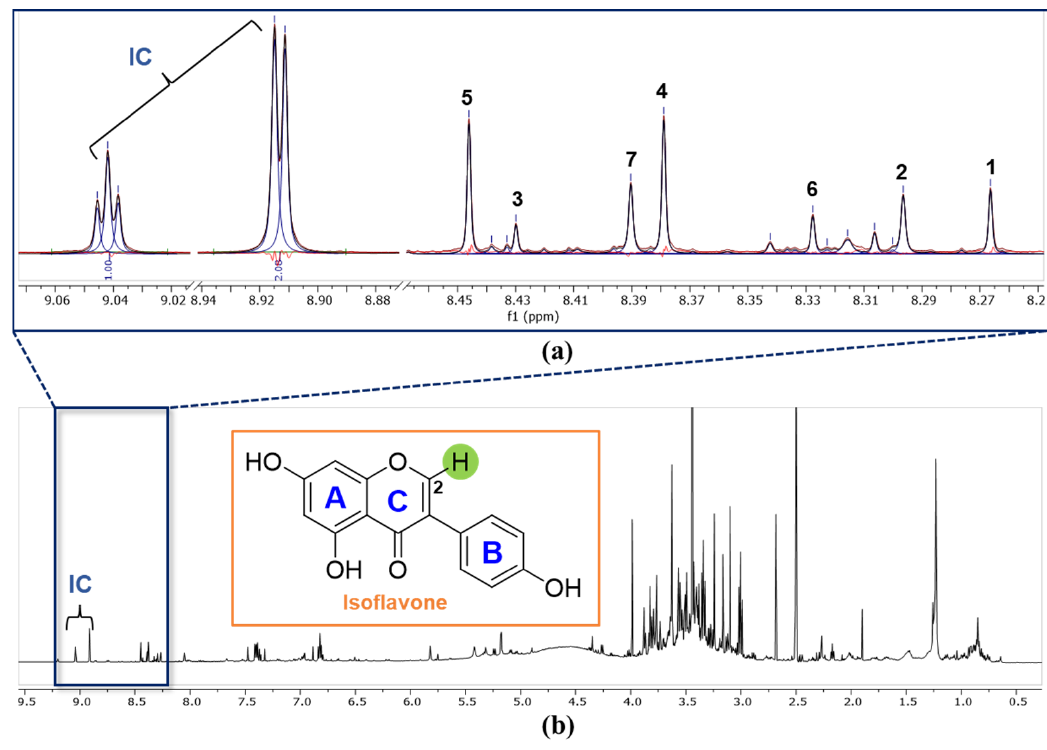
Figure 4. ( a ) Expansion of the resonances for H-2 and IC: The region for the deconvoluted signals of